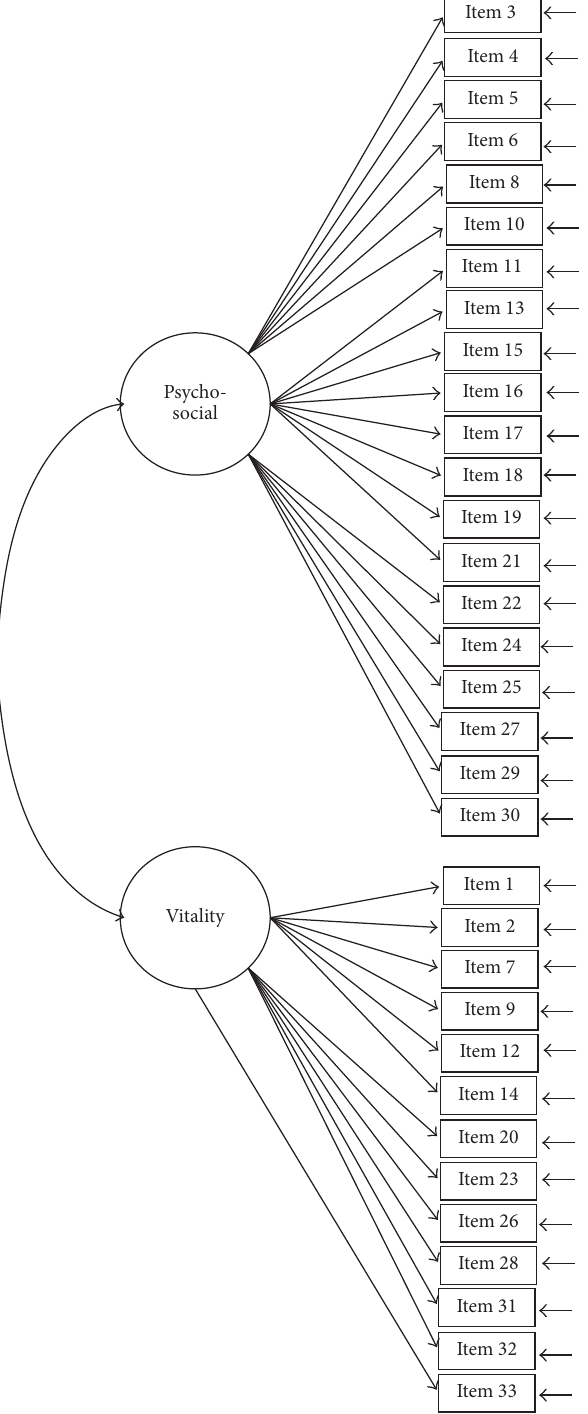
Figure 1: Model 1: the two-correlated-factor model with 33 items. Item descriptions are in Table